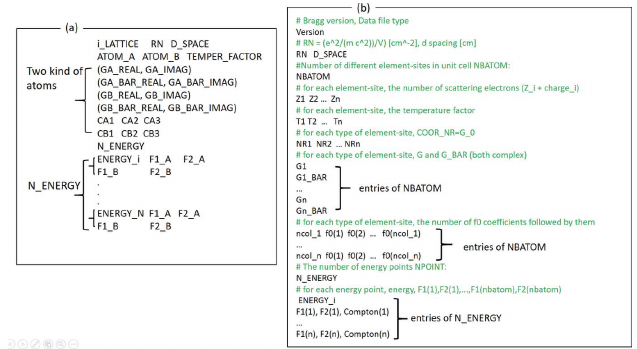
Figure 3 The original ( a ) and new ( b ) formats of a SHADOW preprocessor file. The new format file includes a comment explanation following each line of parameters. The index or the prototypical atoms goes from 1 to NBATOM , and ncol i represents the number of f 0 coefficients for a particular prototypical atom (it must be an odd number, typically 9 or